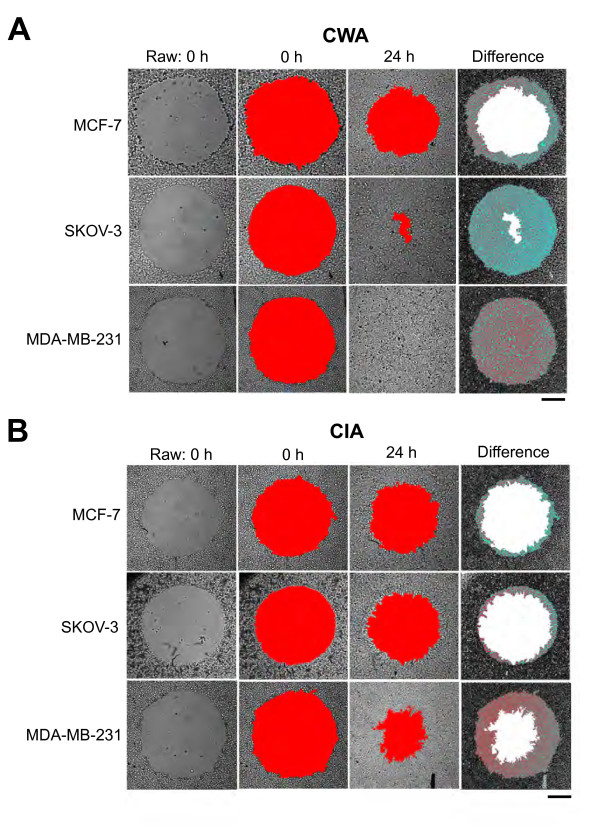
Image analysis techniques and quantification method application. Time-lapse images were obtained using a Zeiss Axiovert 200 M (2.5× Plan-NEOFLUOR objective, NA 0.075; scale bar = 500 μm) from application of the CWA (A) and CIA (B) methods. Each row of each panel represents one of three cell lines with various levels of aggressiveness (MCF-7, SKOV-3, and MDA-MB-231) captured at 0 h, 24 h, and the difference measured (in pixels) between the areas of those time points. The original, untouched wound for each cell line at 0 h is included in column 1 of each panel. The highlighted red regions (columns 2 and 3) indicate the pseudo-color applied (via ImageJ) to the wounded areas at both 0 h and 24 h, and the blue regions (column 4) indicate the differences (in area) obtained between those time points. Clearly, the Matrigel™ overlay has a considerable effect on wound closure of these cell lines.